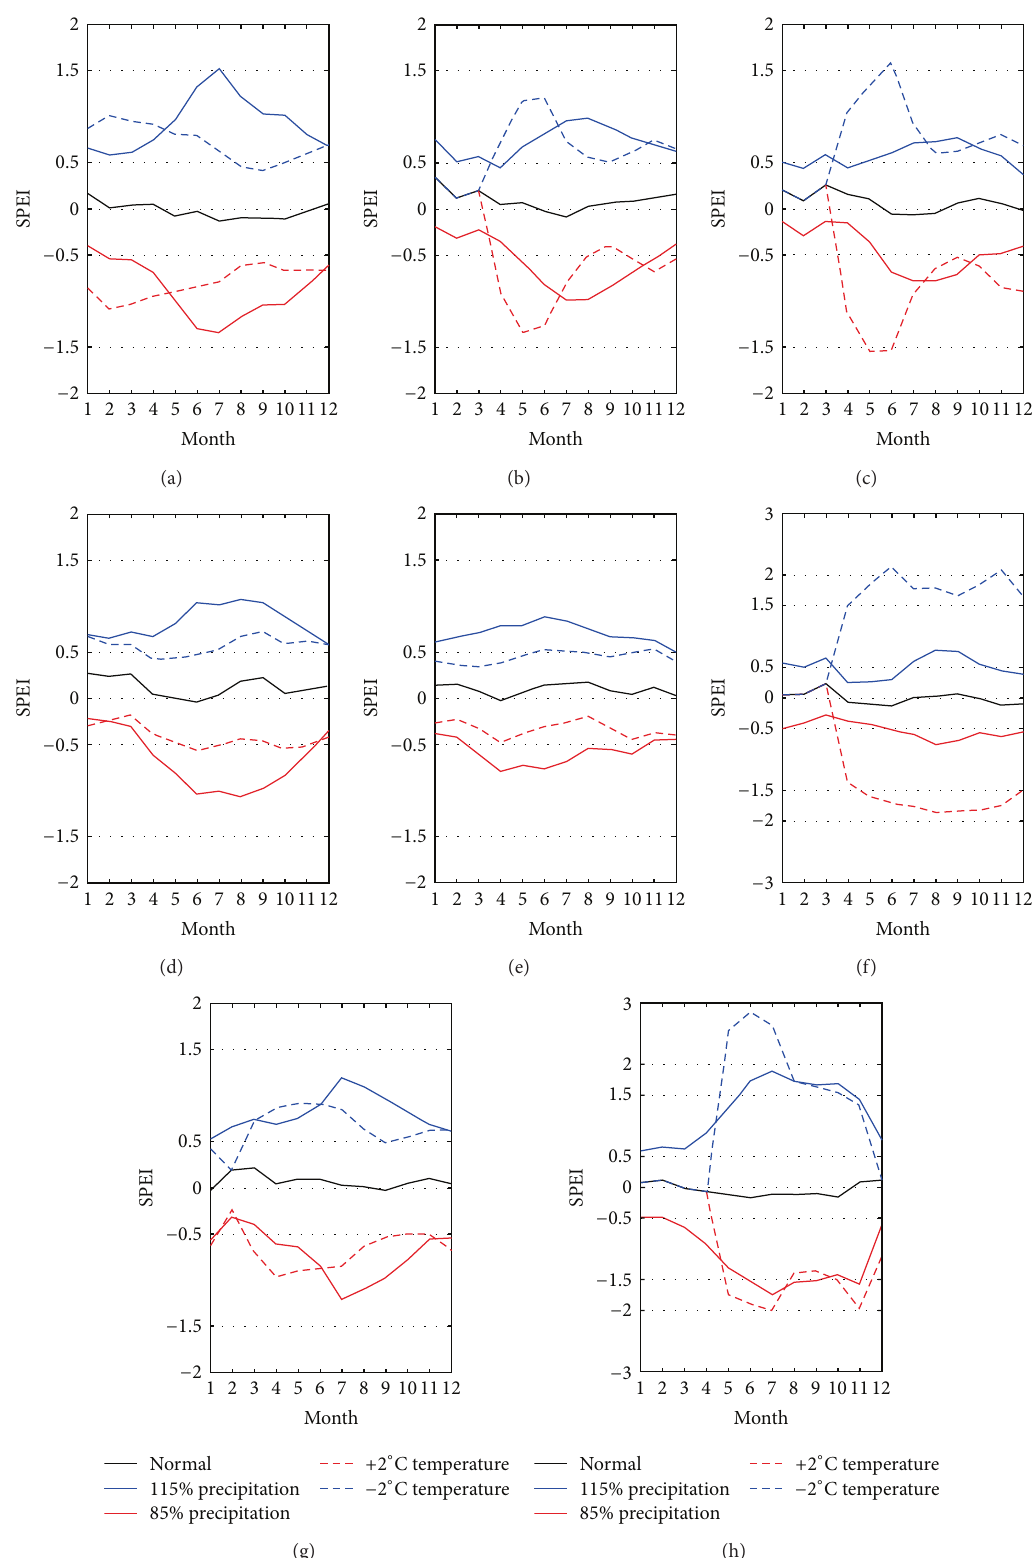
Figure 10: Evolution of the SPEI in eight regions under five scenarios: (a) SW; (b) NE; (c) N; (d) SE; (e) YR; (f) NW; (g) C; (h)